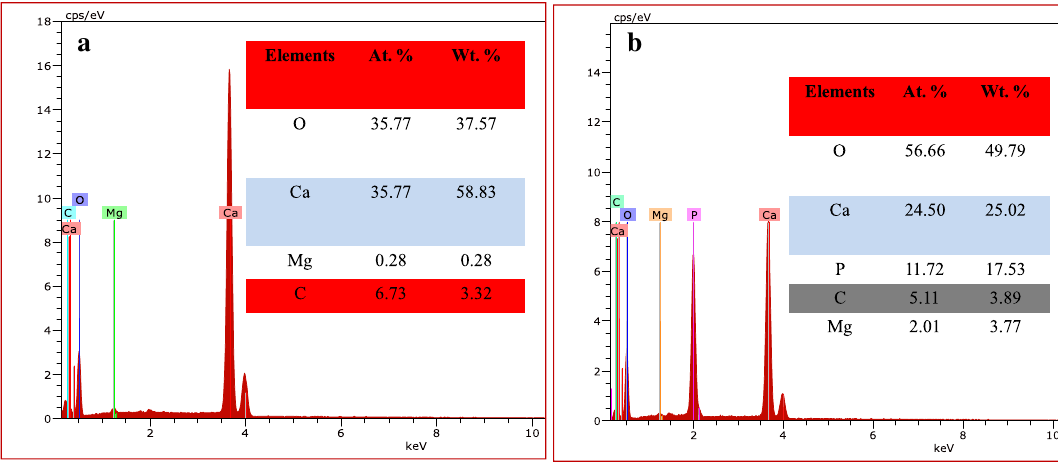
Fig. 7 EDX of a snail shell and b carbonated apatite derived from snail